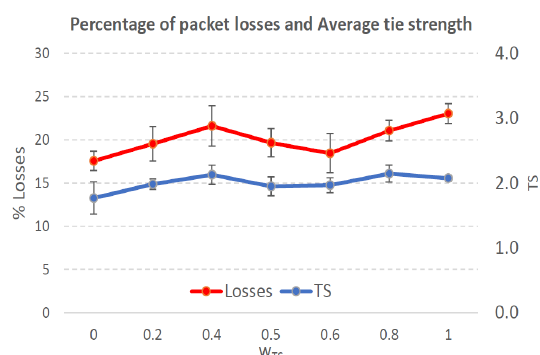
Figure 10. Percentage of packet losses and average tie strength of the forwarding path. Scenario with low social media interaction (TS normal distribution with µ = 2 and σ = 1). Nodes’ density = 200 nodes/km 2 .